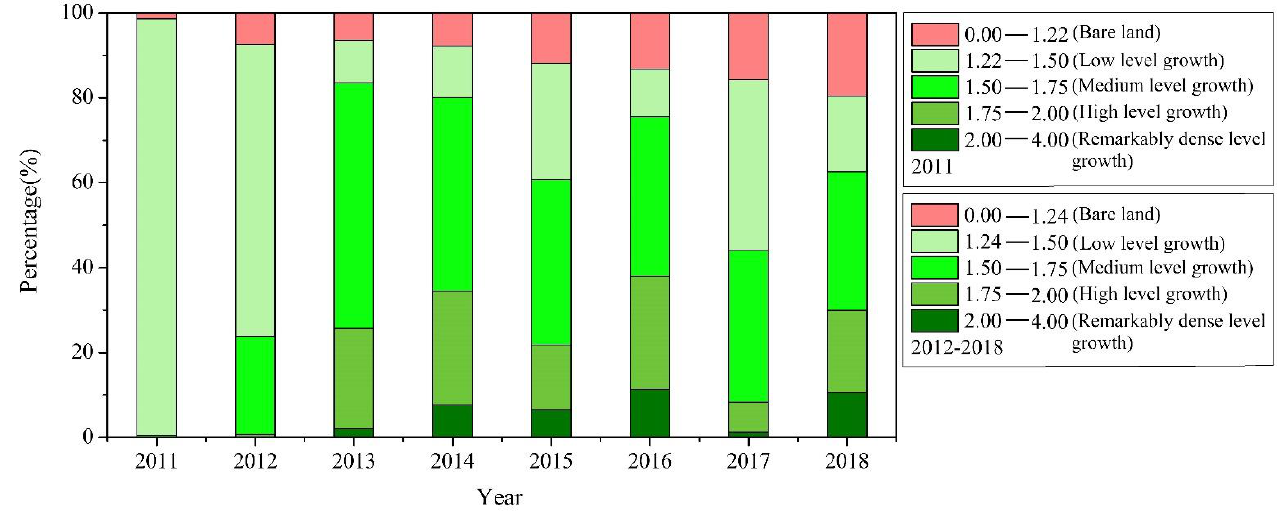
Figure 6. Statistics of changes in vegetation growth from 2011 to 2018 in the study region.